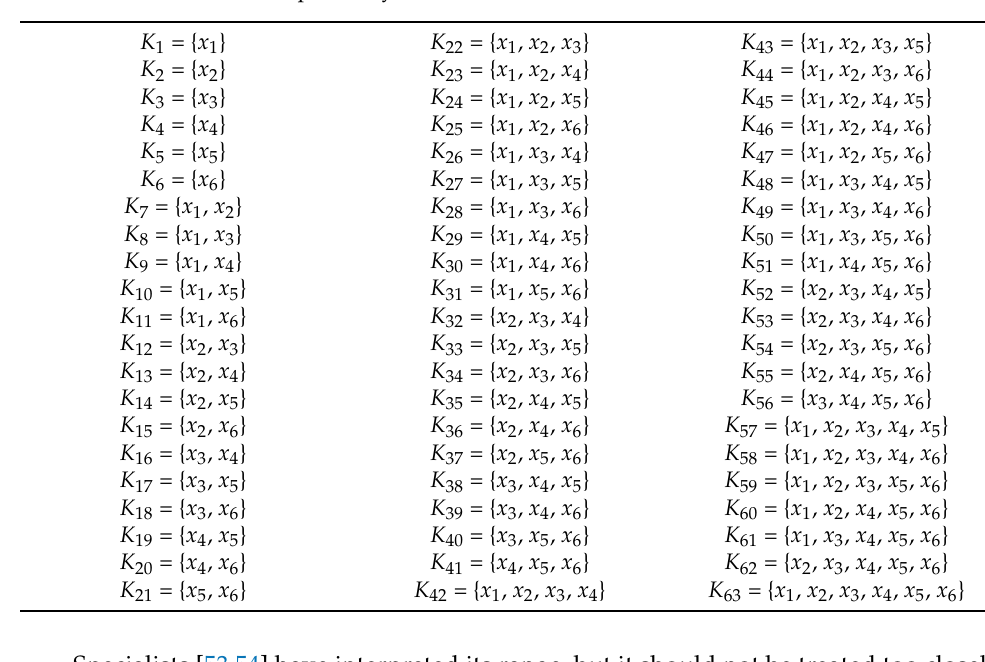
Table 3. Combinations of explanatory